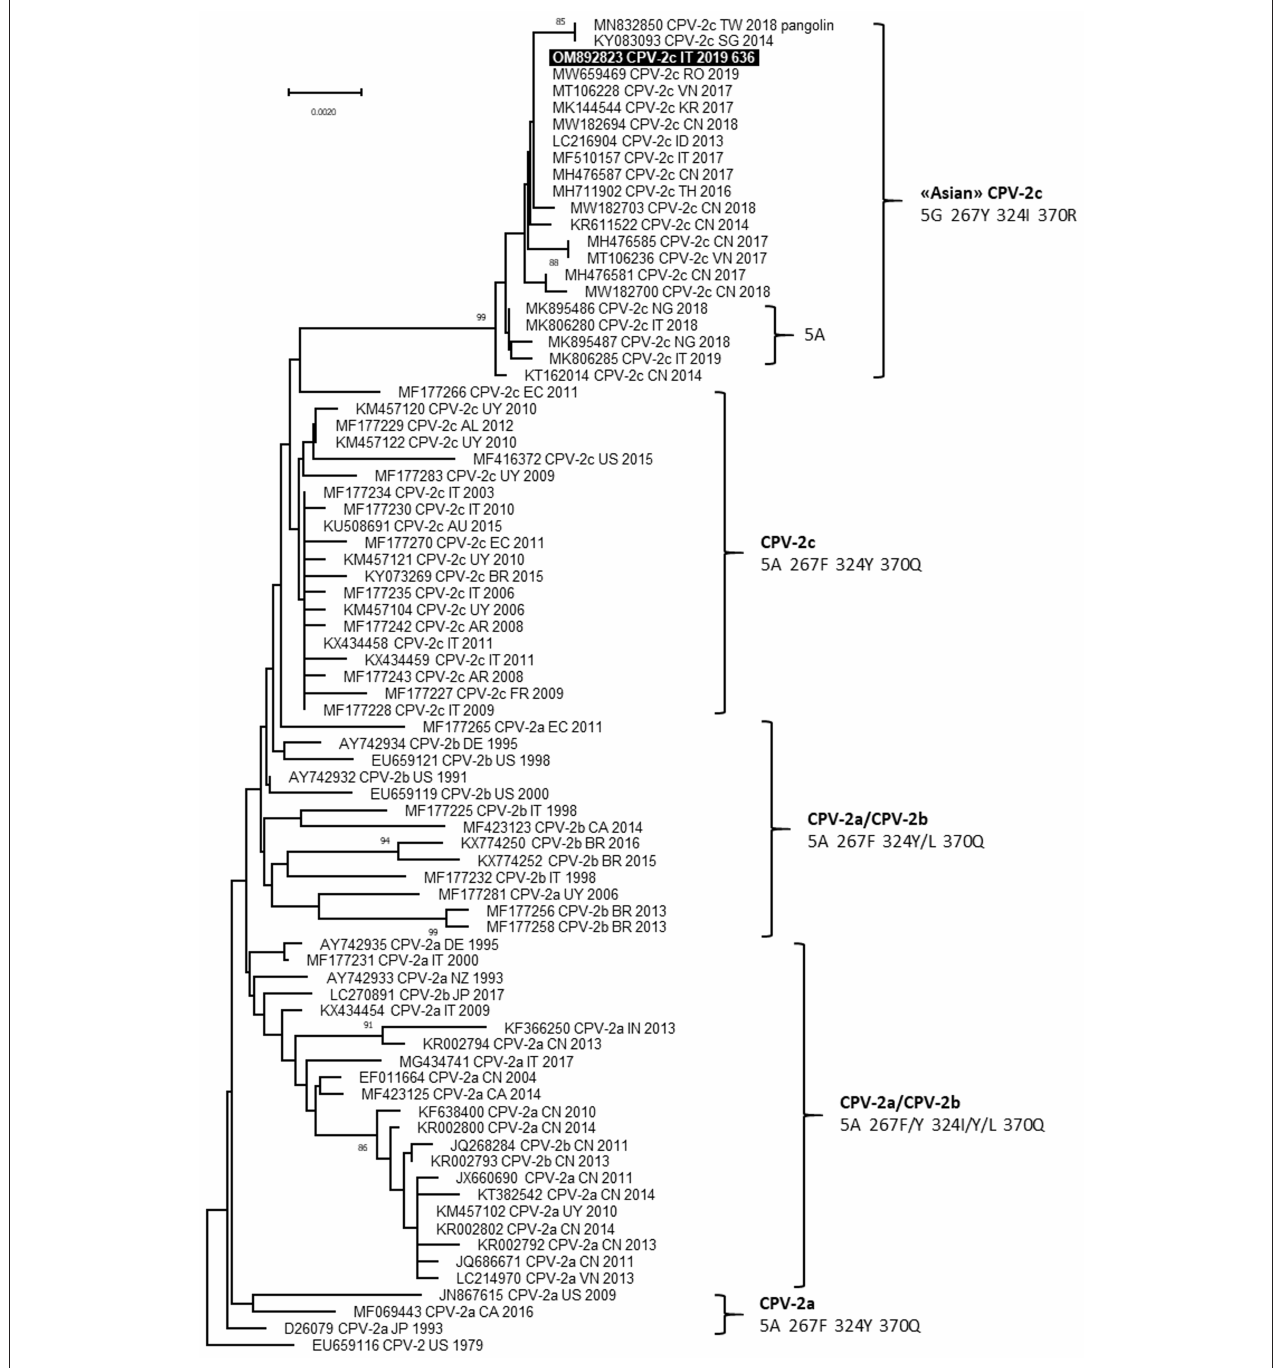
FIGURE 2 | Phylogenetic tree based on the complete VP2 gene nucleotide sequences of canine parvovirus type 2 (CPV-2) obtained in this study and reference strains retrieved from GenBank database. Phylogeny was constructed by MEGA 11 version 11.0.11 using Neighbor-Joining method and the Tamura 3-parameters (T92 model with gamma distribution. Statistical support was provided by bootstrapping with 1,000 replicates. Bootstrap values > 80% are indicated on the respective branches. Highlighted in black: Sequences generated in this study (only the viral sequence identified in Dog 1 is reported because the nucleotide sequences obtained from the two dogs were identical). The CPV-2 antigenic variants and the amino acid residues in positions 5, 267, 324 and 370 of deduced VP2 protein are reported for each cluster.